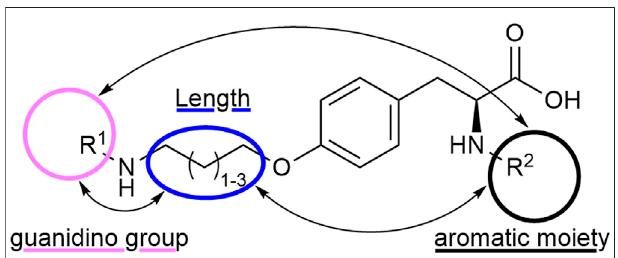
FIGURE 3 | RGD mimetic lead structure with the highlighted variegating